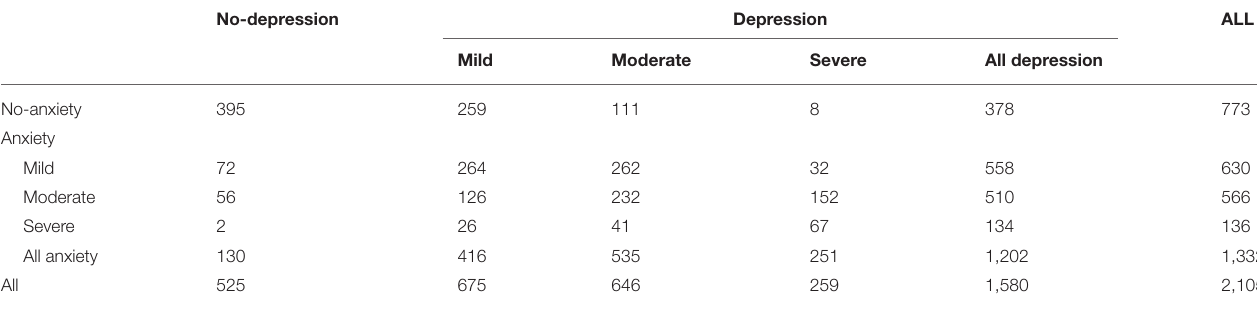
TABLE 2 | Proportion and severity of anxiety and depression in all patients ( n = 2,105). No-depression Depression ALL Mild Moderate Severe All